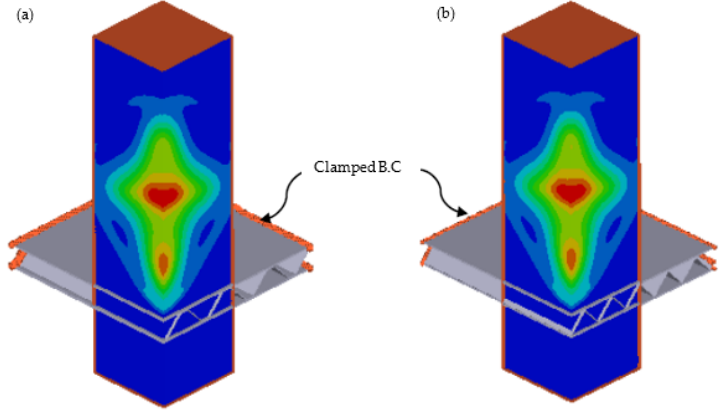
Figure 3. Three-dimensional FE models for the sandwich structures. ( a ) TZ-panel. ( b ) T-panel.